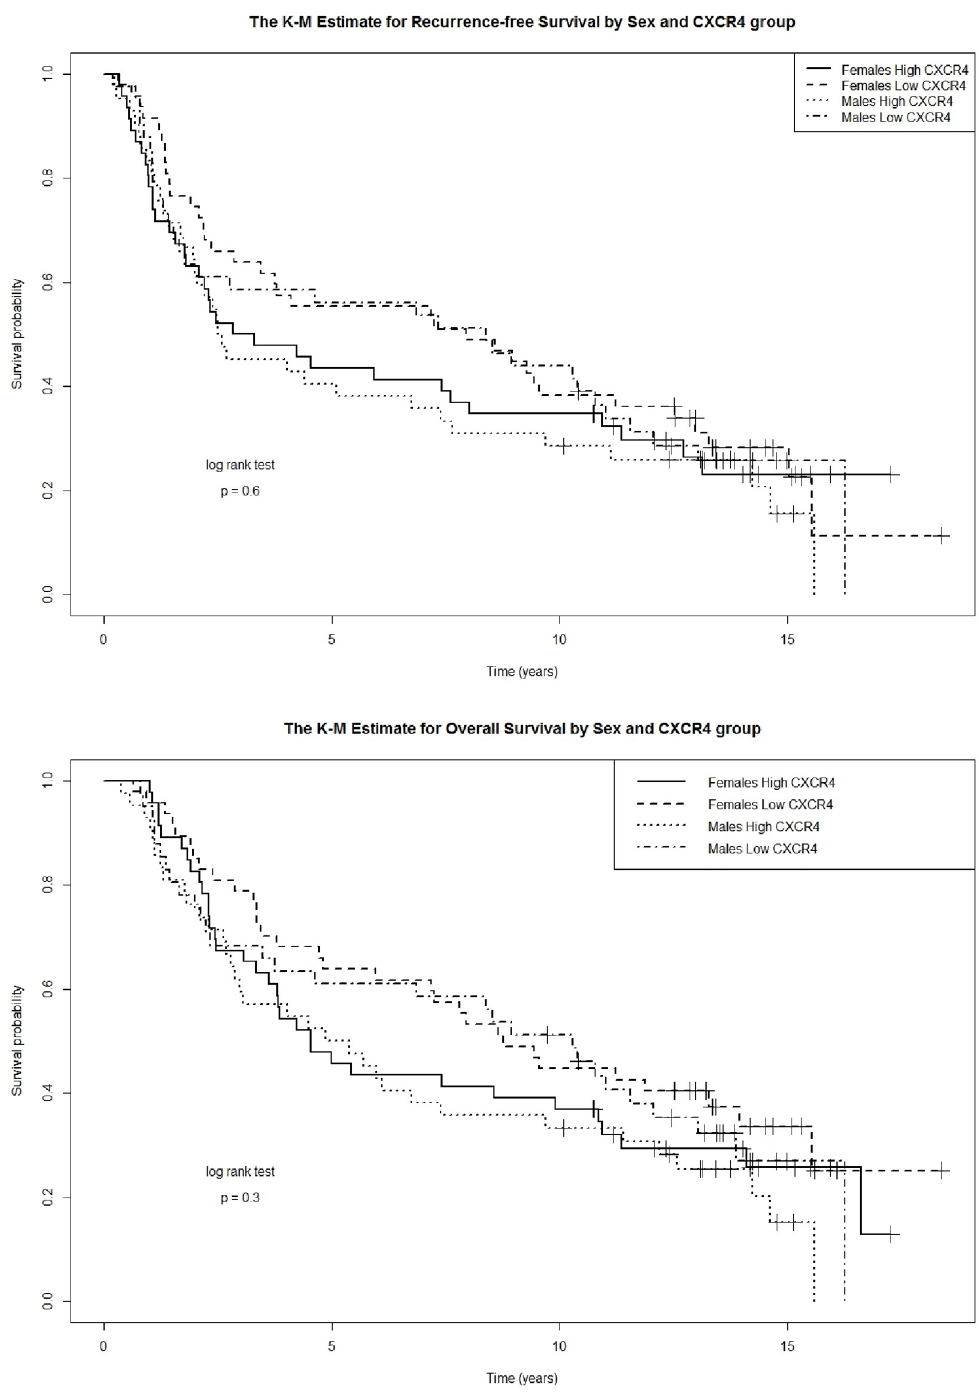
Fig 4. No gender-specific difference in survival outcomes by CXCR4 expression. There was no difference in recurrence- free survival (top panel) or overall survival (bottom panel) based on gender in patients with high or low levels of CXCR4 expression based on median